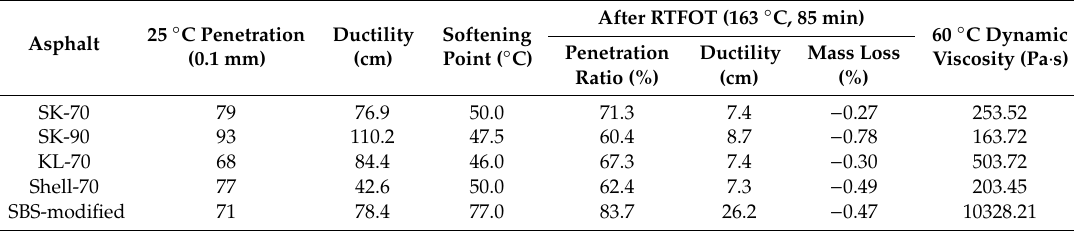
Table 1. Performance Index of